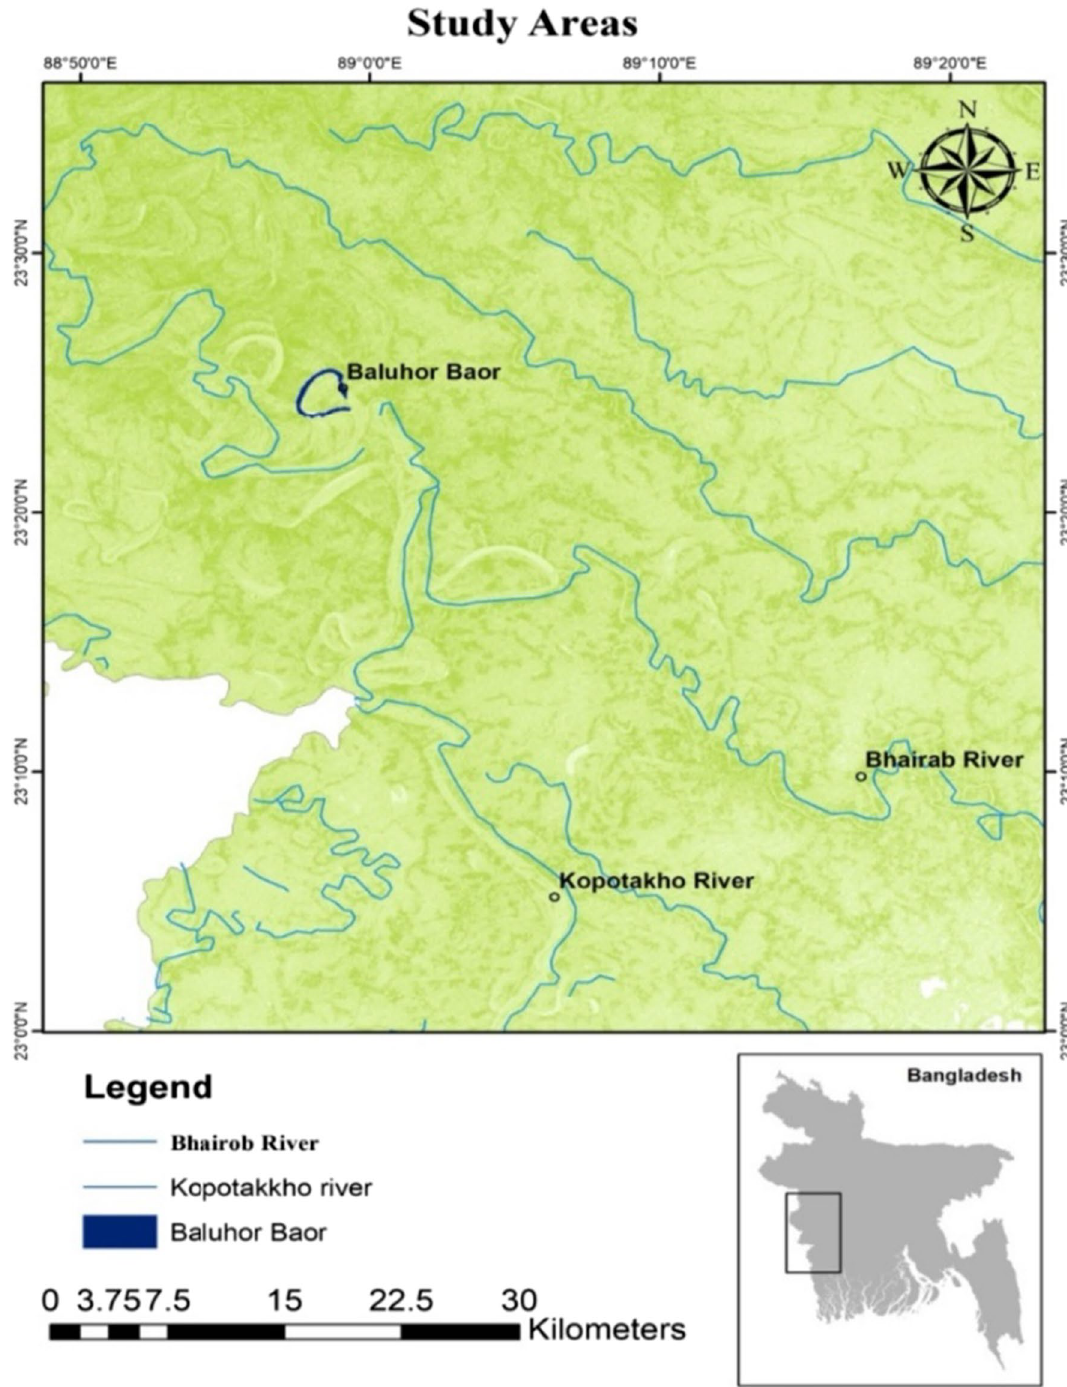
Fig. 1 Study area map showing the H. limbatus sampling sites in